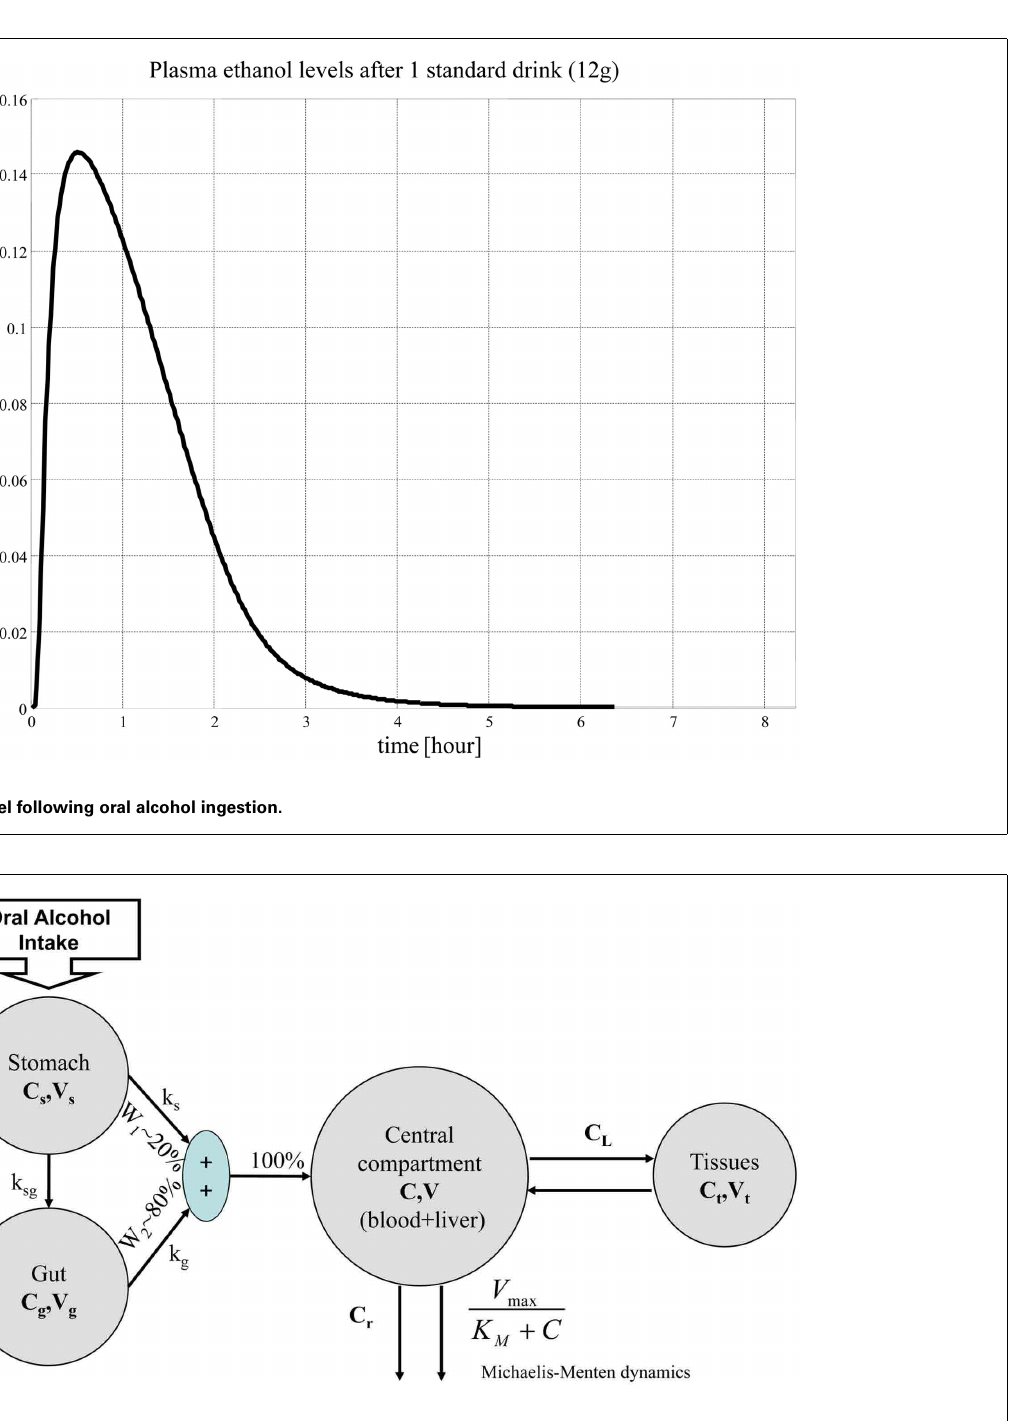
FIGURE 6 |The minimal model of ethanol dynamics following oral alcohol intake.